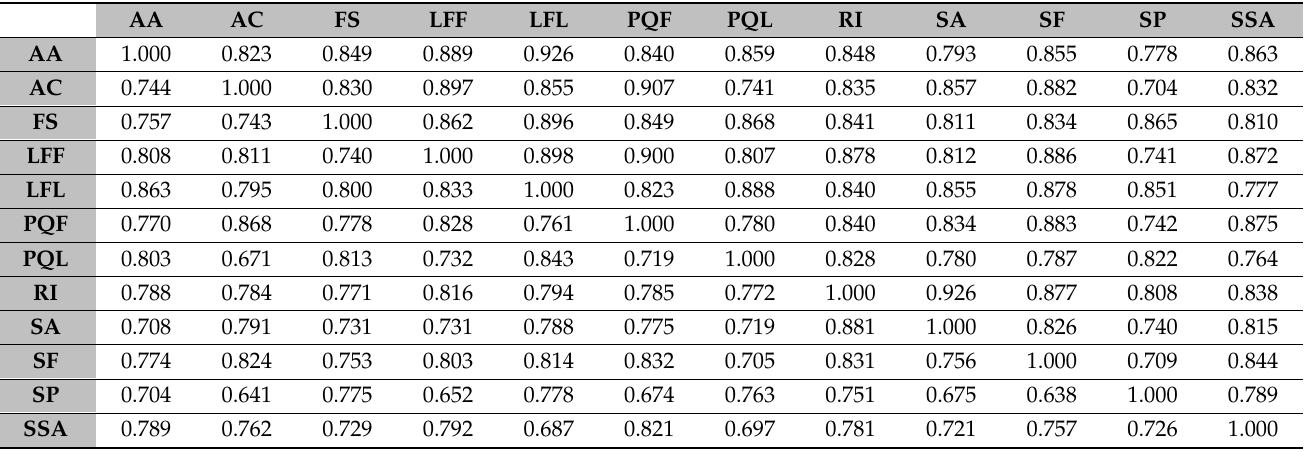
Table 5. HTMT2 Discriminant Validity Test Result (lower diagonal: HTMT2 value; upper diagonal: upper bound of the 90% confidence